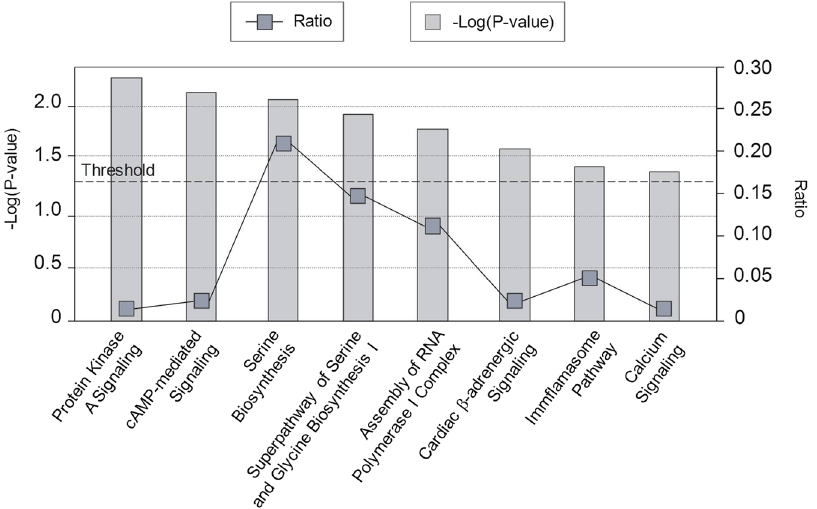
Figure 1. Enriched canonical pathways (P-value < 0.05) considering 40 genes from the gene-wide analyses surpassing follow-up significance threshold (P-value < 1e-03). The − log(P-value) from the Fisher’s exact test for each enriched category is indicated by grey bars. The ratio indicates the number of genes tested that map to the canonical pathway divided by the total number of genes that map to that pathway, and is represented by dark grey squares.